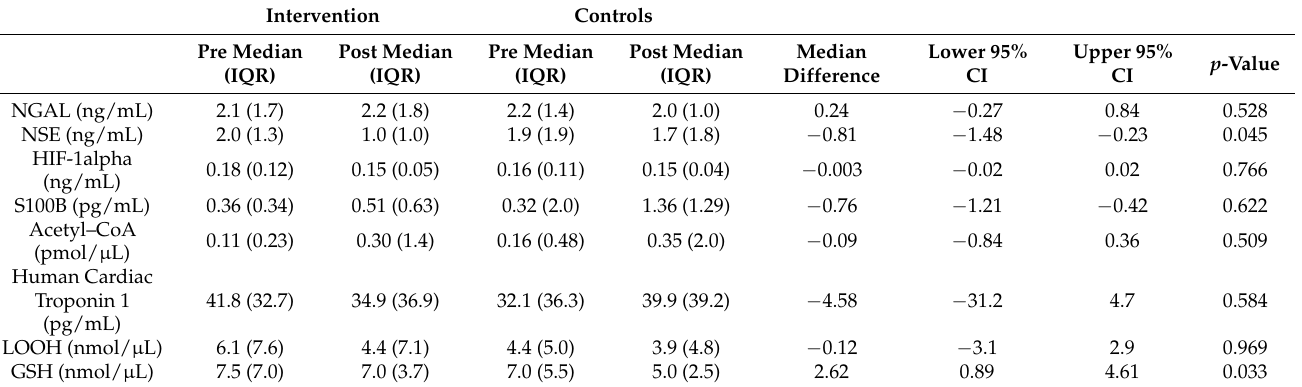
significance (Table 4). Table 4. Differences between pre- and post- surgery of biochemical markers of inflammation in intervention and control